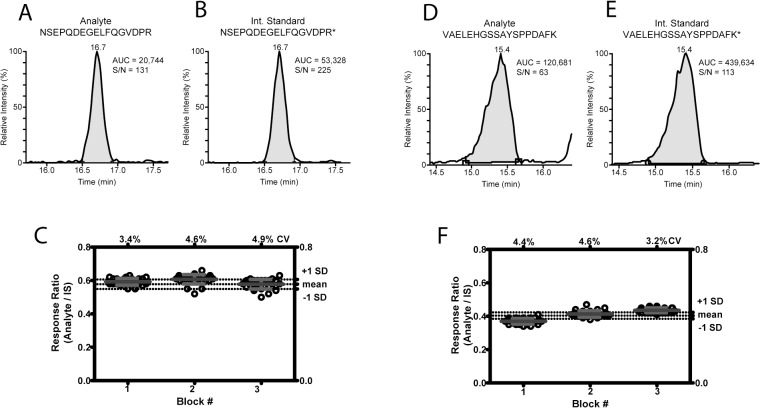
SRM mass spectrometry based assay to quantitate SME1 and SME2 from human CSF.Example total ion current chromatograms for peptide (A) NSEPQDEGELFQGVDPR from neurosecretory protein VGF (SME1) and (B) the corresponding stable isotope labeled internal standard peptide; and (D) VAELEHGSSAYSPPDAFK from Neuronal Pentraxin Receptor (SME2) and the corresponding internal standard peptide (E) measured by SRM. The observed signal corresponds to the injection of a 4μL equivalent of CSF on column with an internal standard concentration of 26 nM. The peak area (AUCs) measured using LCQuan are shown in grey for each peak. A signal-to-noise ratio measured for the endogenous NSEPQDEGELFQGVDPR and VAELEHGSSAYSPPDAFK was 131 and 63, respectively. Analysis 90 individual technical replicates of 100μL CSF (C) and (F). Response ratios were determined for 90 technical replicates of CSF. Samples were processed in 3 blocks of 30 samples. The mean value (blue line) and standard deviation (red error bars) are shown for each block. The mean value and standard deviation for all samples (black dashed line) is shown on the right hand vertical axis. The coefficient of variation is indicated for each block on the top horizontal axis. Within and between block variability, as determined by ANOVA, is shown on the bottom of each plot.